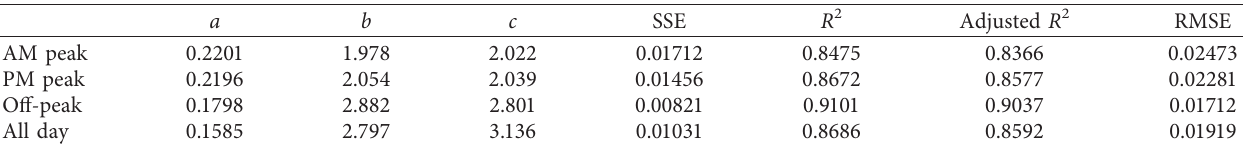
Table 3: Fitting